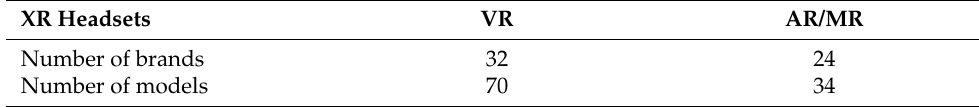
Table 4. XR headsets released on the market in the period